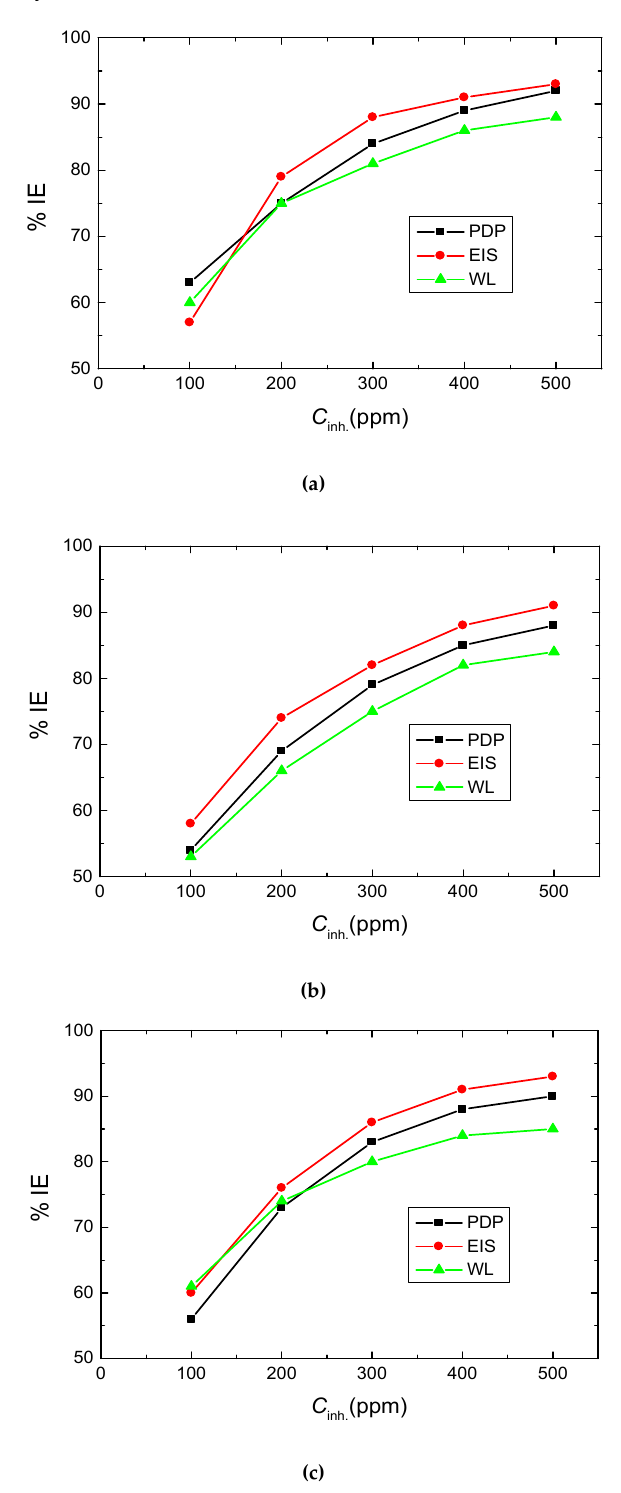
Figure 10. Comparison of different techniques used for evaluation of %IEs of the three polymers tested for inhibition mild-steel corrosion in 0.5 M HCl at 303 K. (a) Chi, (b) Pec and (c) A-Pec.